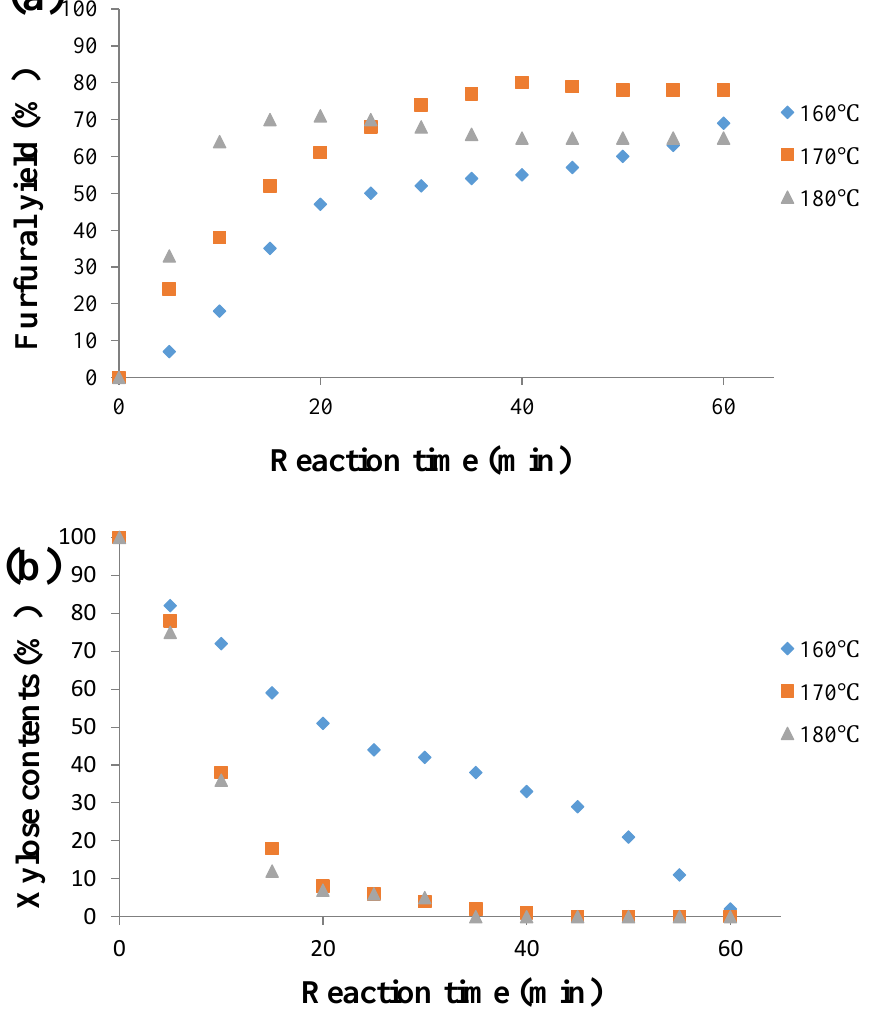
Figure 2. Effect of reaction time and temperature on ( a ) furfural yield and ( b ) xylose contents. Reaction conditions: Nafion NR50 (2 pellets), NaCl (95 mg), D -xylose (1.0 mmol), water (1 mL), CPME (3 mL) and MW.